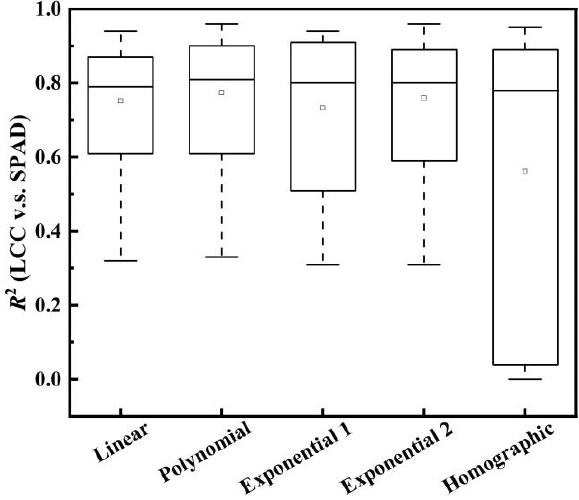
Figure 4. Boxplots for the coefficients of determination of five functions for the relationships between LCC and SPAD readings based on the model assessments of field datasets from three aspects: (i) all datasets together, (ii) individual datasets from three different data sources, and (iii) individual vegetation species. Central lines represent the medians, boxes represent 50% of the data, squares represent mean values, and whiskers represent minimum and maximum values. Table 4. Assessments of the linear function based on all datasets together, individual datasets, and each species per dataset in terms of three field